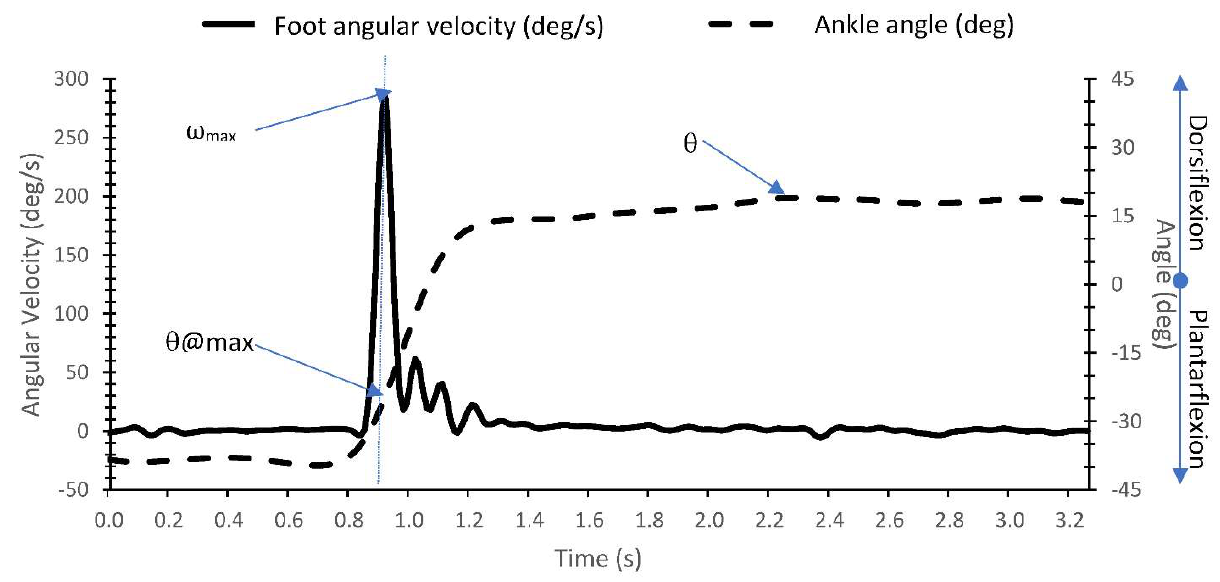
Figure 5. Identification of maximum foot angular velocity ( ω max ), angle at maximum angular velocity ( θ @max), and angle at maximum DF ( θ ) from the IMU acceleration and angular velocity measurements.